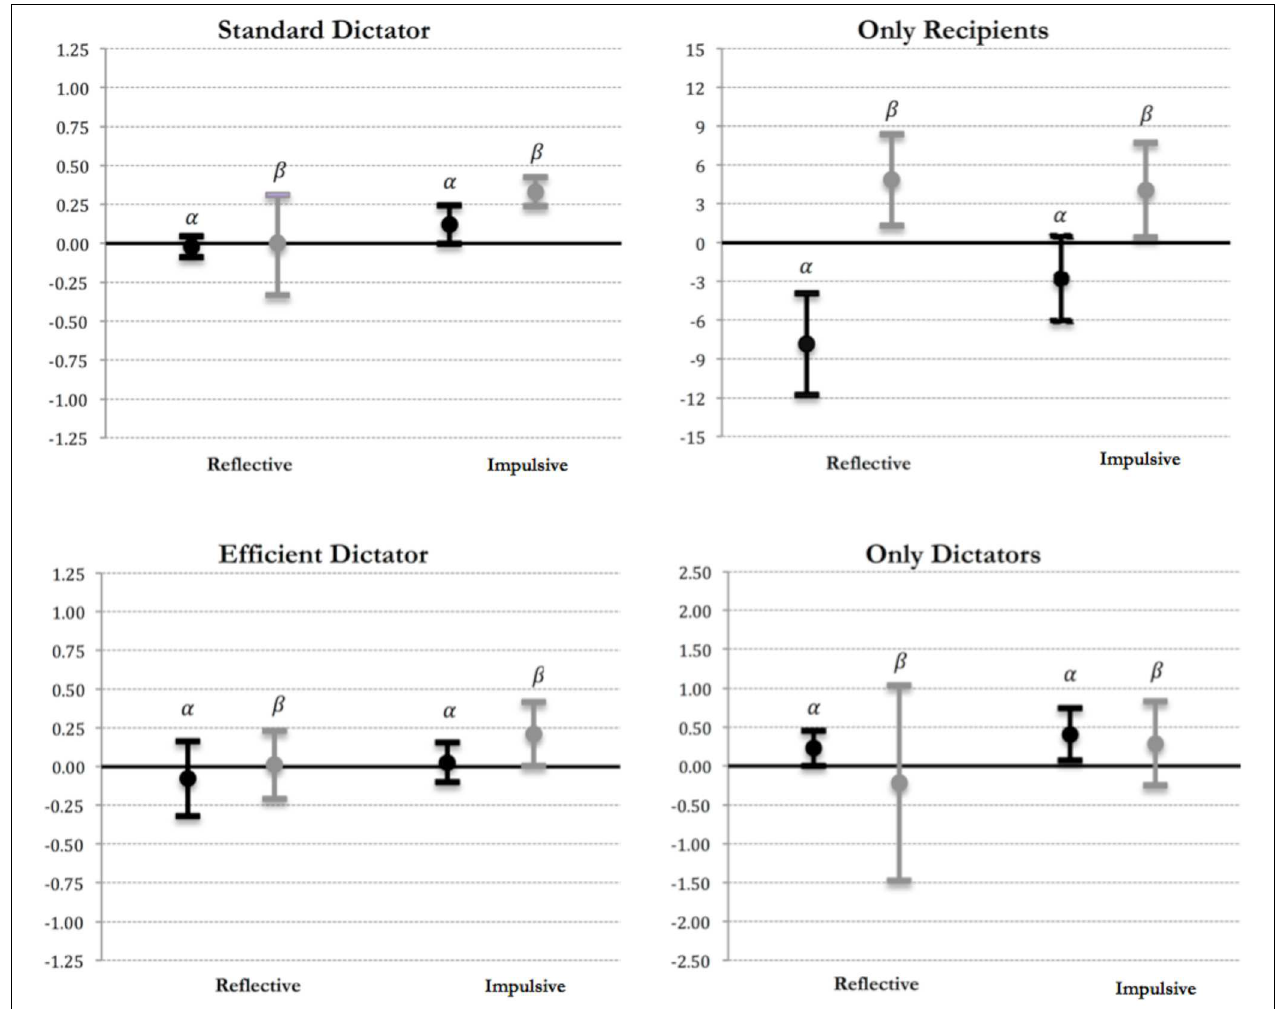
FIGURE 1 | Estimates of Fehr and Schmidt (1999) in each type of game. Point estimates and confidence intervals for envy ( α ) and guilt ( β ) are reported in black and gray,